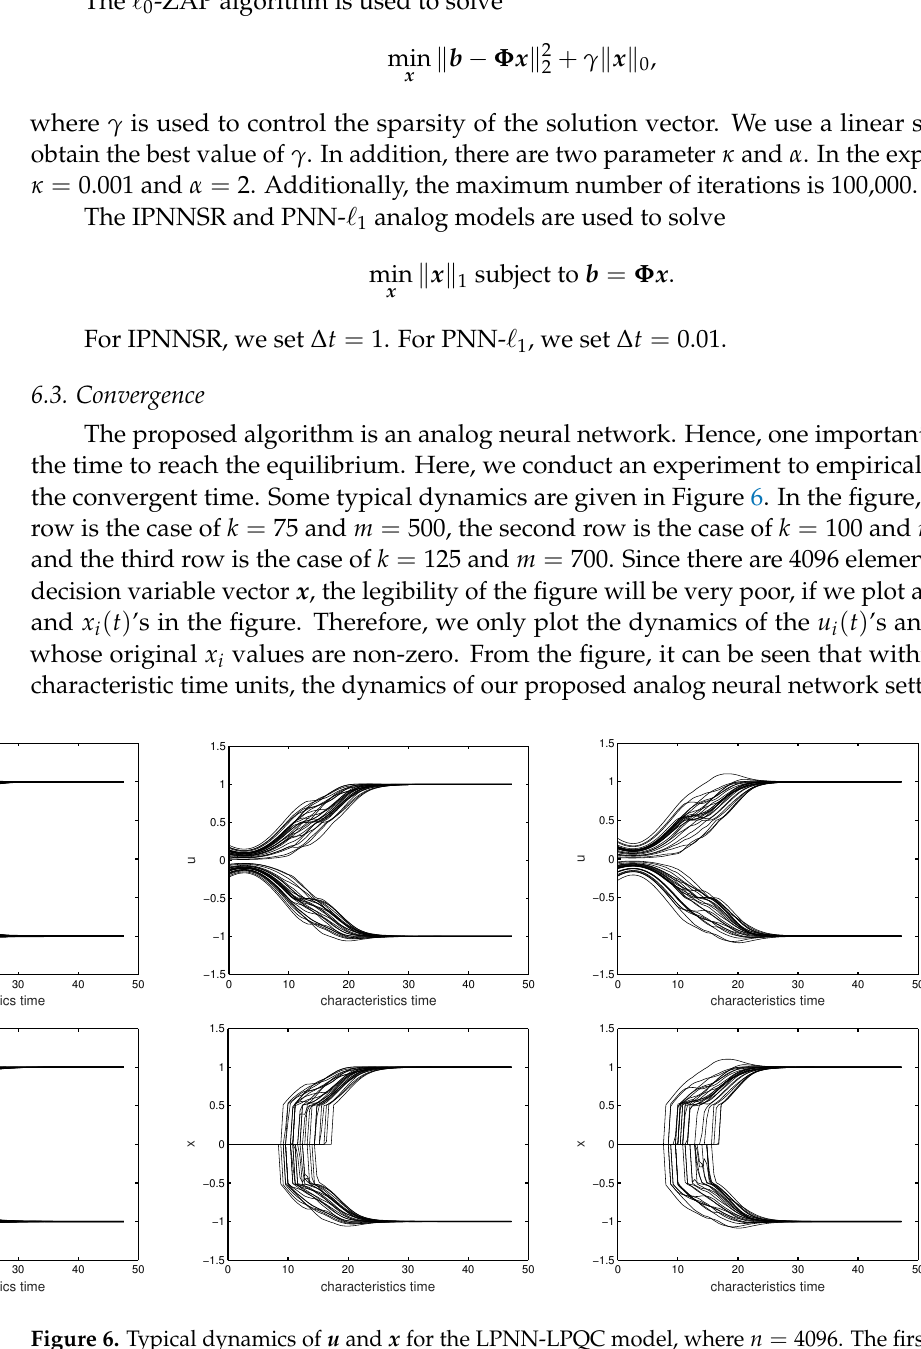
Figure 6. Typical dynamics of u and x for the LPNN-LPQC model, where n = 4096. The first column: k = 75, m = 500. The second column: k = 100, m = 600. The third column, k = 125, m = 700. In all sub-figures, we only show the dynamics of the u i ’s and x i ’s whose original x i values are non-zero, because there are 4096 curves in each sub-figure when we show all the dynamics for u i ’s and x i